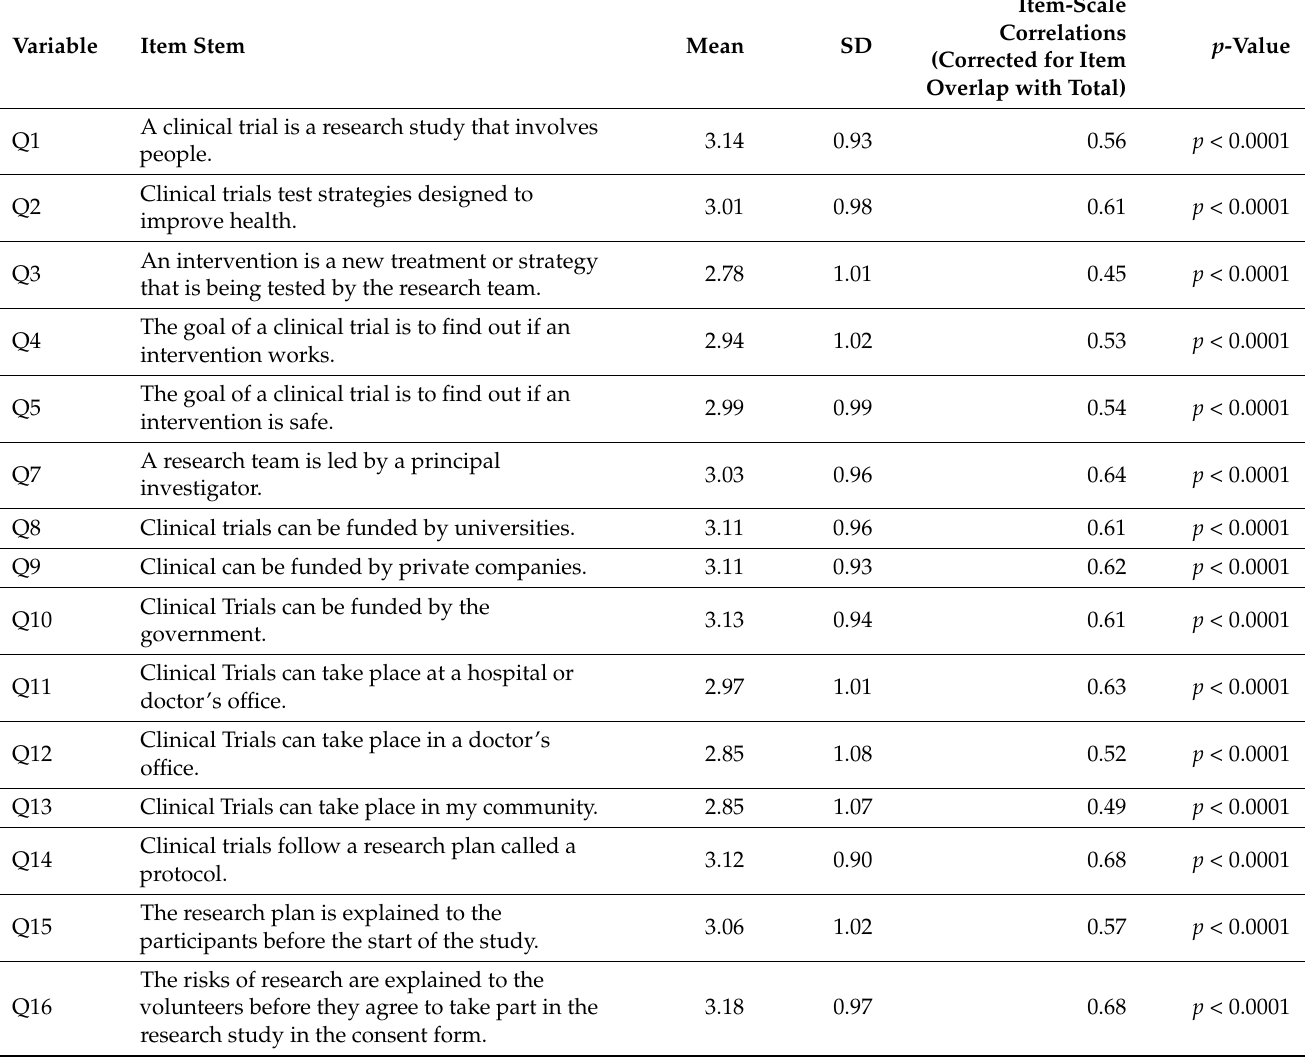
Table A3. Descriptive Statistics and Item-Scale Correlations for the 25-item